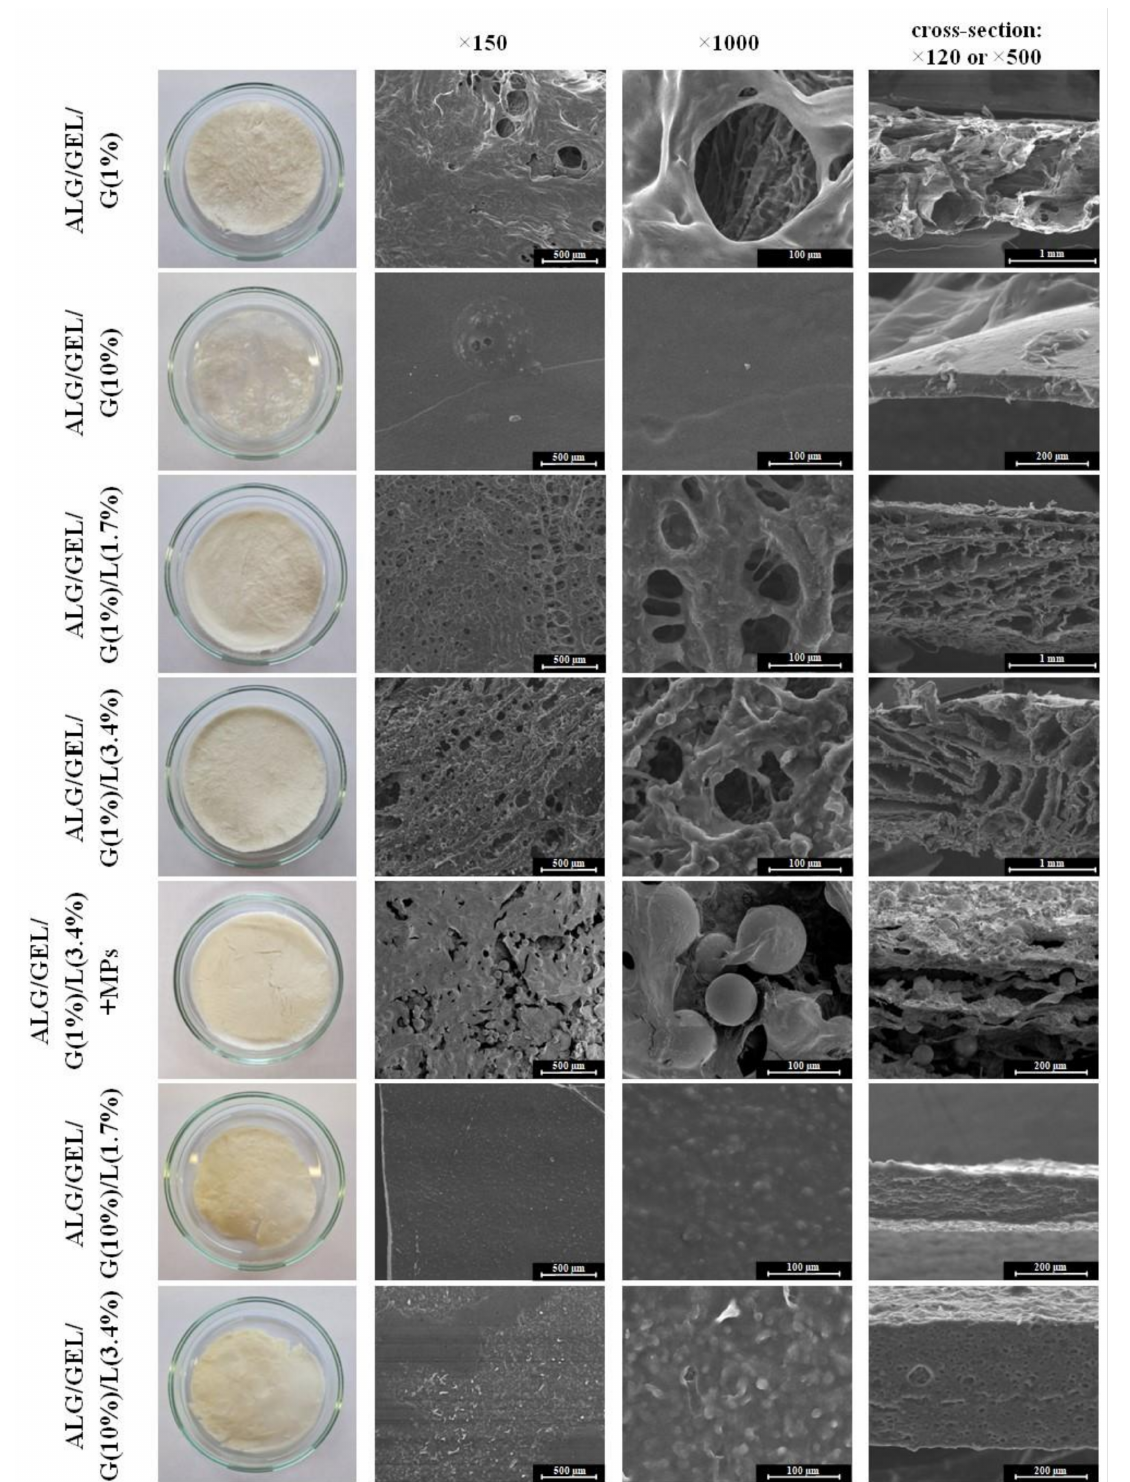
Figure 2. Photographs of obtained freeze-dried matrices after cross-linking and SEM images of their structure in magnifica- tion × 150 (scale bar = 500 µ m), × 1000 (scale bar = 100 µ m) and cross-sections in magnification × 120 (scale bar = 1 mm) or × 500 (scale bar = 200 µ